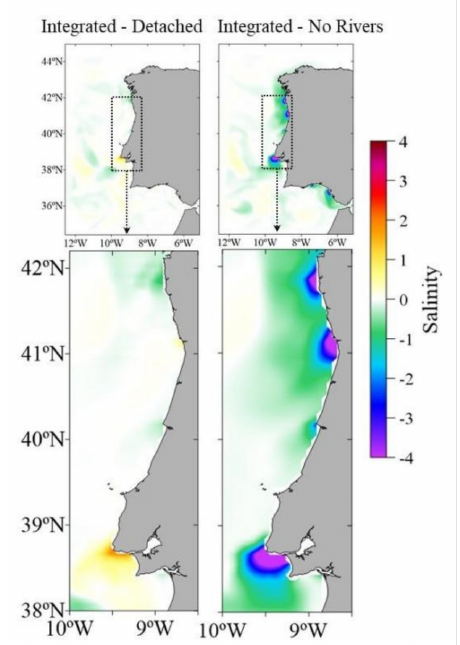
Figure 7. Difference between average surface salinity maps for the entire domain (top) and a zoom over the area of interest in the west coast of the IP ( bottom ) produced by: integrated minus detached ( left ) and integrated minus no-rivers ( right ) over the peak flow period (18 March to 1 April